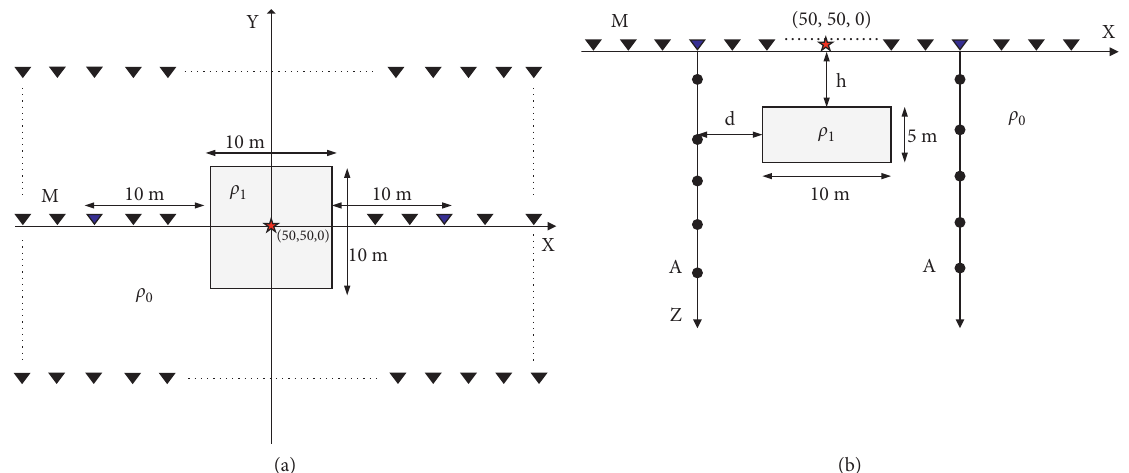
Figure 5: Geometrical model of a flat surface with a cube. (a) XOY plane view of the model; (b) XOZ cross-sectional view of the